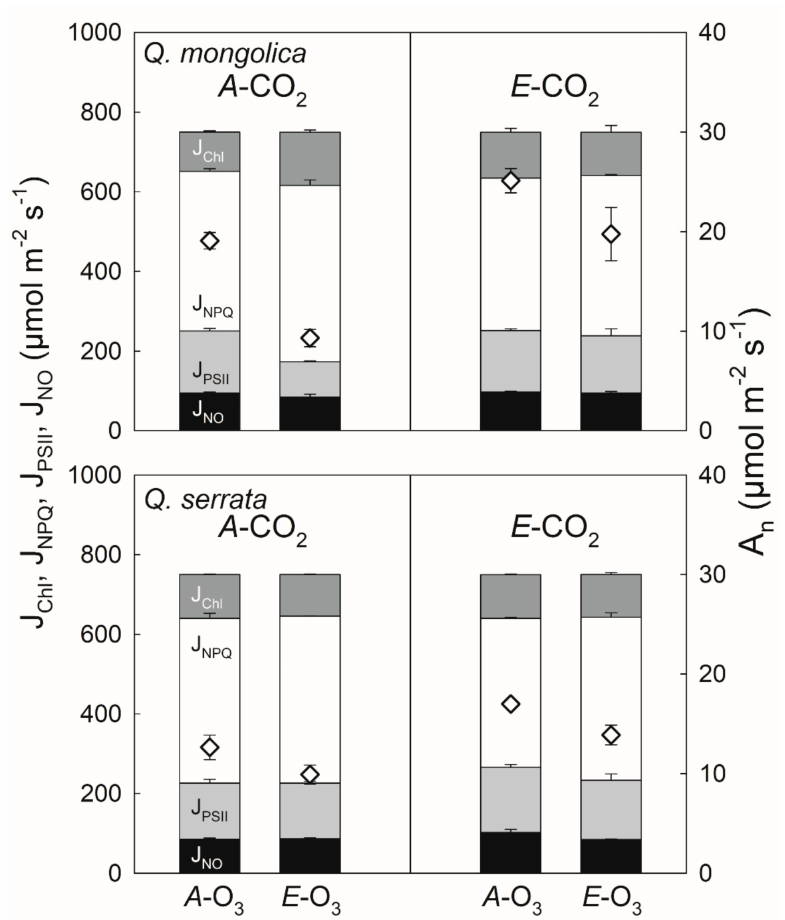
Figure 3. Fate of light energy partitioning under elevated O 3 and CO 2 . Here, J Chl , J NPQ , J PSII and J NO were measured in the seedlings of Japanese oak ( Q. mongolica ) and Konara oak ( Q. serrata )